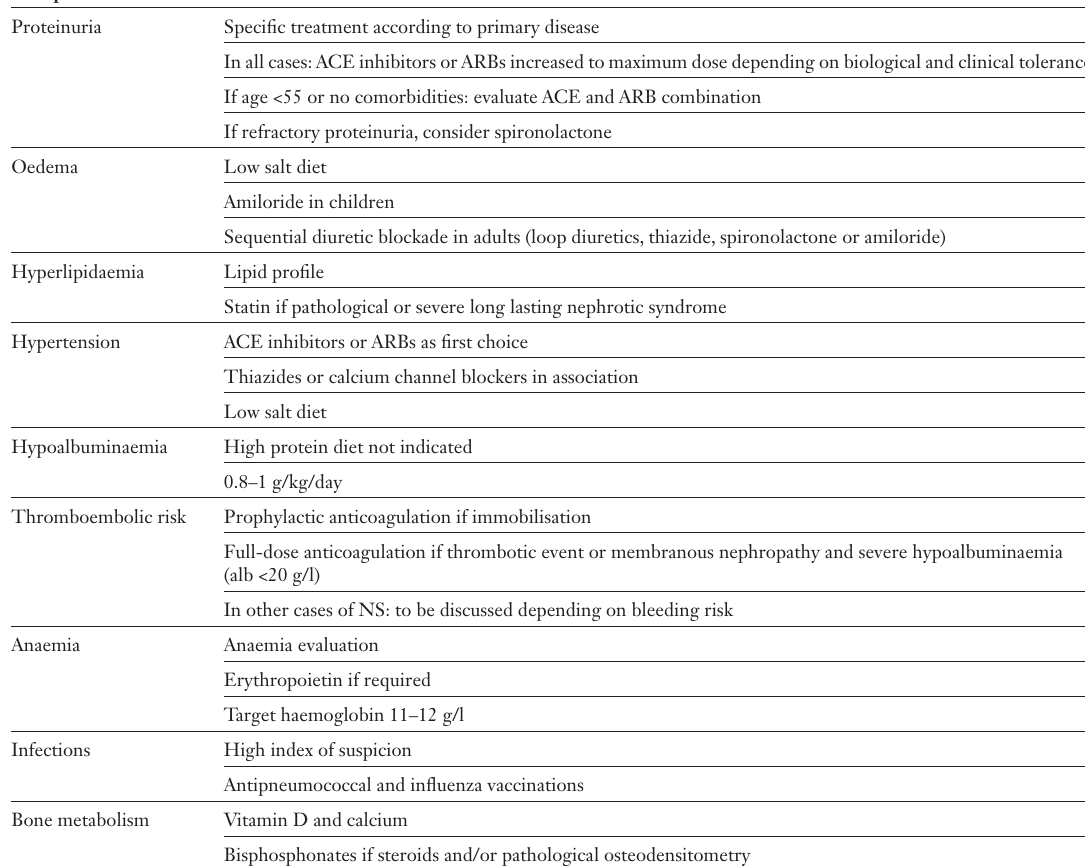
Table 4 Summary of